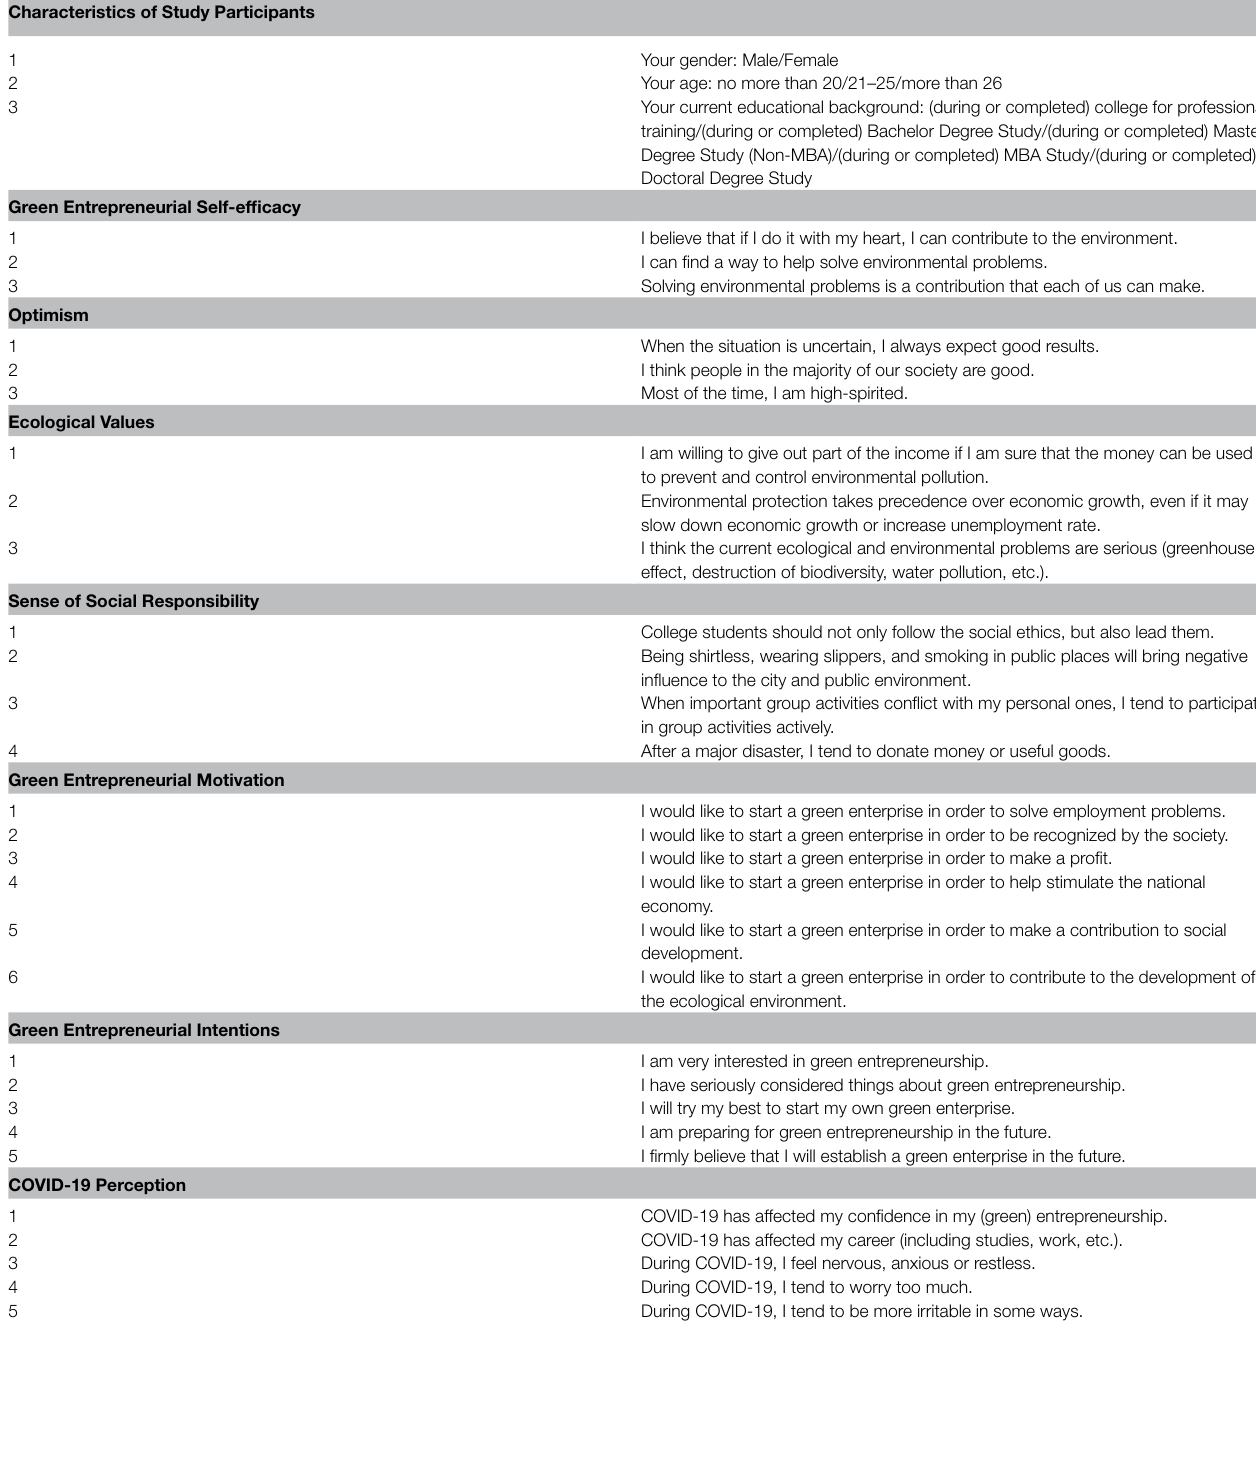
TABLE A1 | Questionnaire. Characteristics of Study